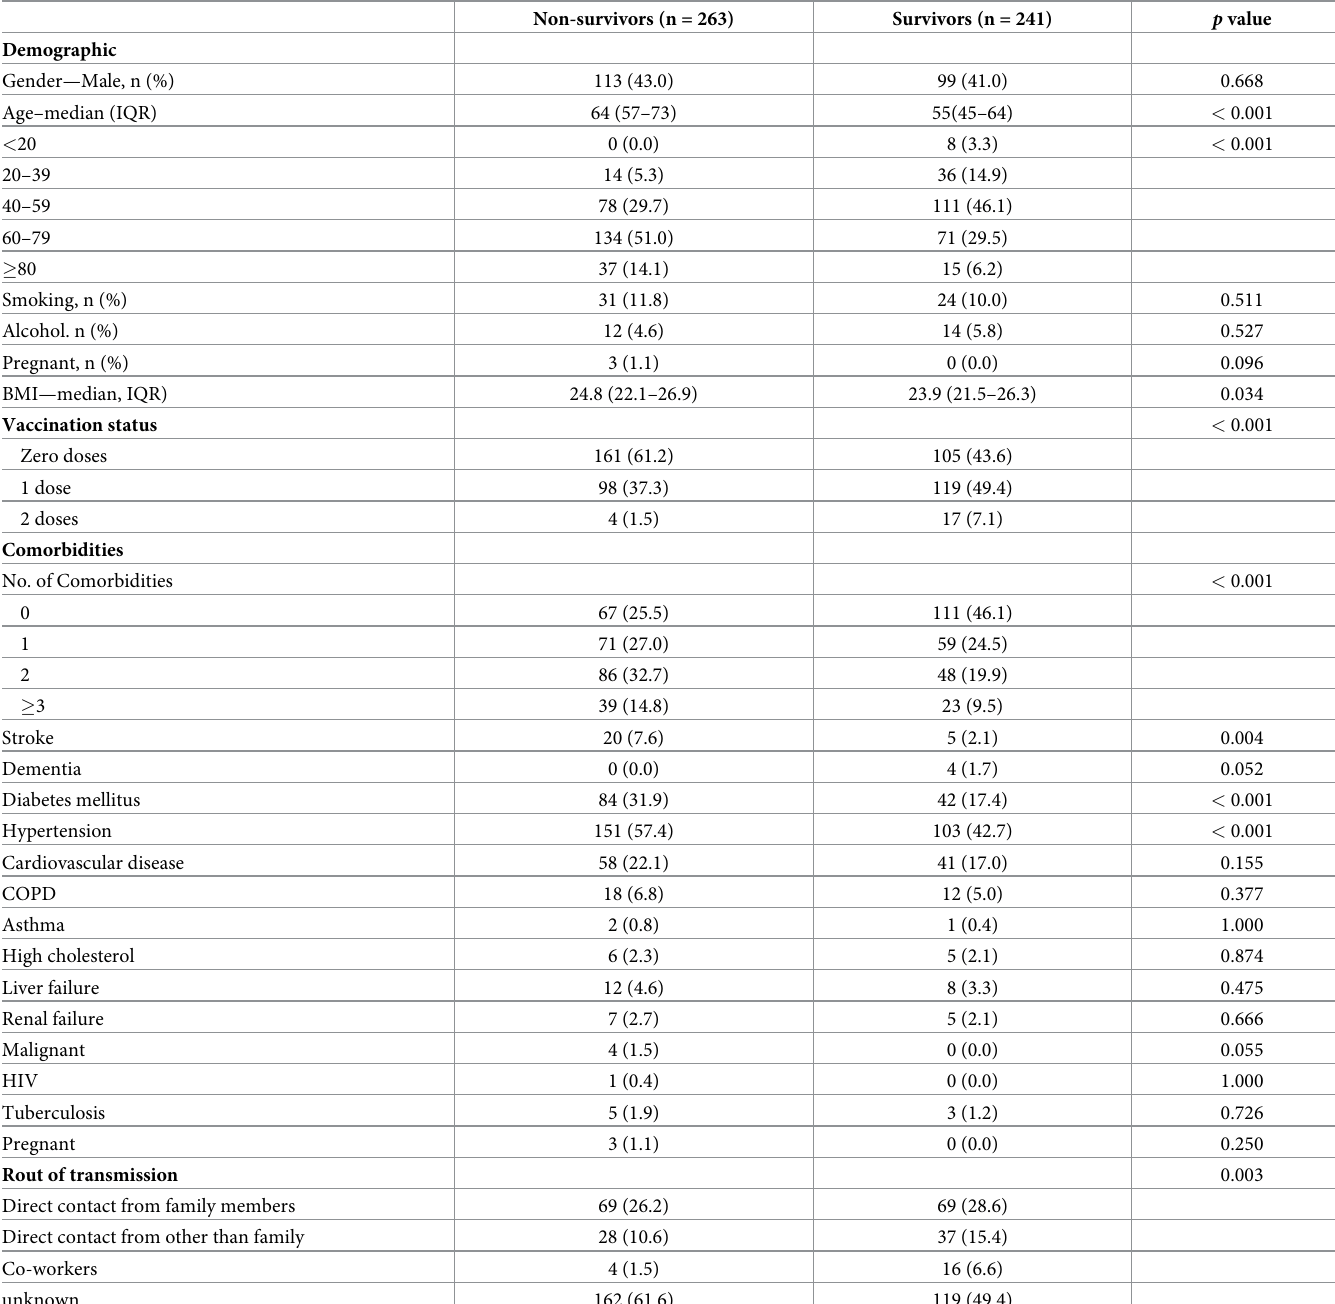
Table 1. Demographic and clinical characteristics of patients with